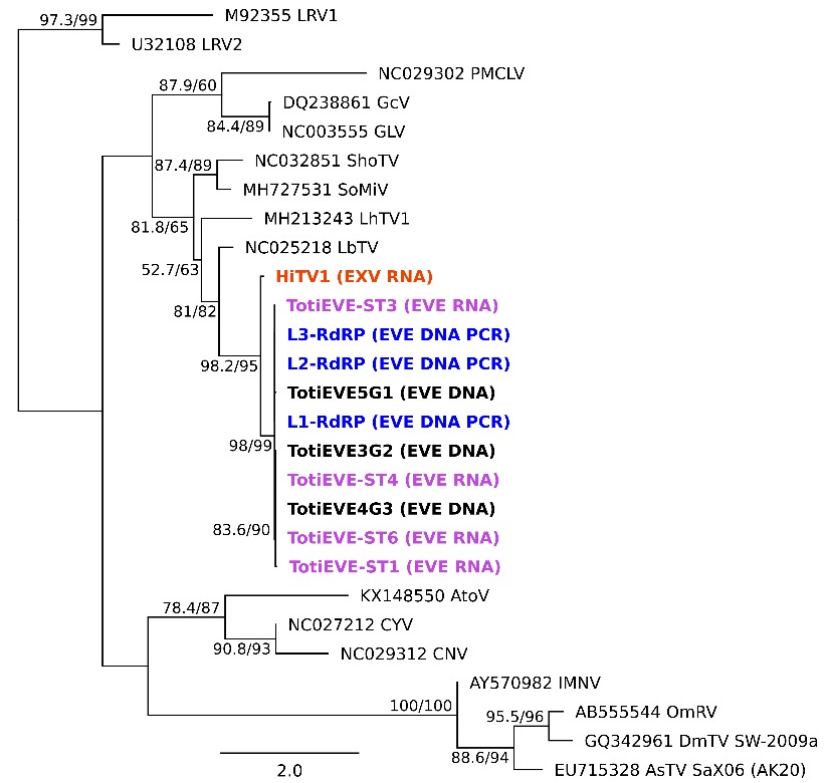
Figure 5. Phylogeny of HiTV1 and endogenous Totivirus sequences located in T1 on BSF genomes. Sequences in bold are associated with this study. HiTV1 is in orange, TotiEVEs located in T1 in the three genomes in black, the expressed TotiEVE ST found in four transcriptomes in purple, and PCR products of T1 from independent BSF samples. The outgroup consisted of LRV1 and LRV2 of the genus Leishmaniavirus within the Totiviridae family. Branch support for the maximum likelihood tree was in the order of SH-aLRT and UF bootstraps. Node values scoring lower than 50 were not dis- played.